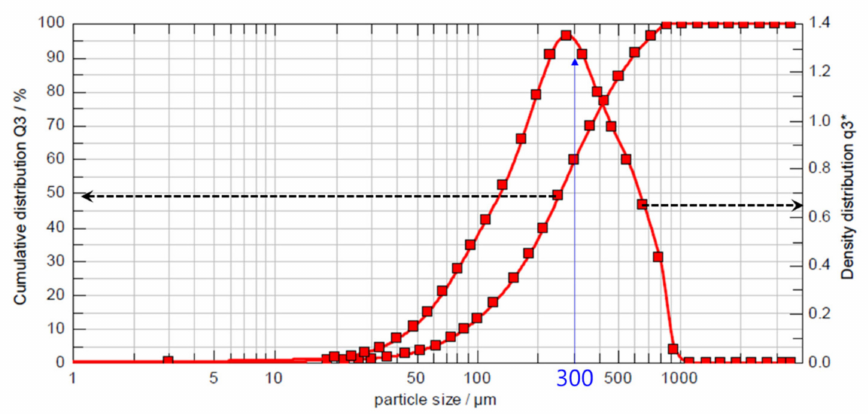
Figure 4. Size distribution of spray droplets from performance tests